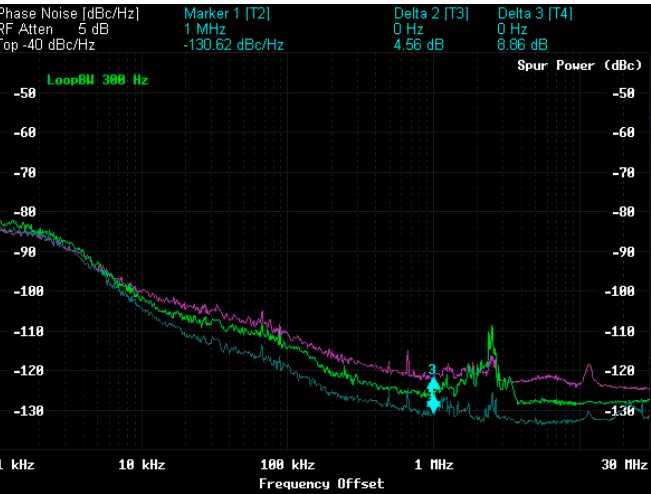
Figure 11. Phase noise comparison at the lower edge (pink curve), the middle range (blue curve), and the upper edge (green curve) of the PLL’s capture range.